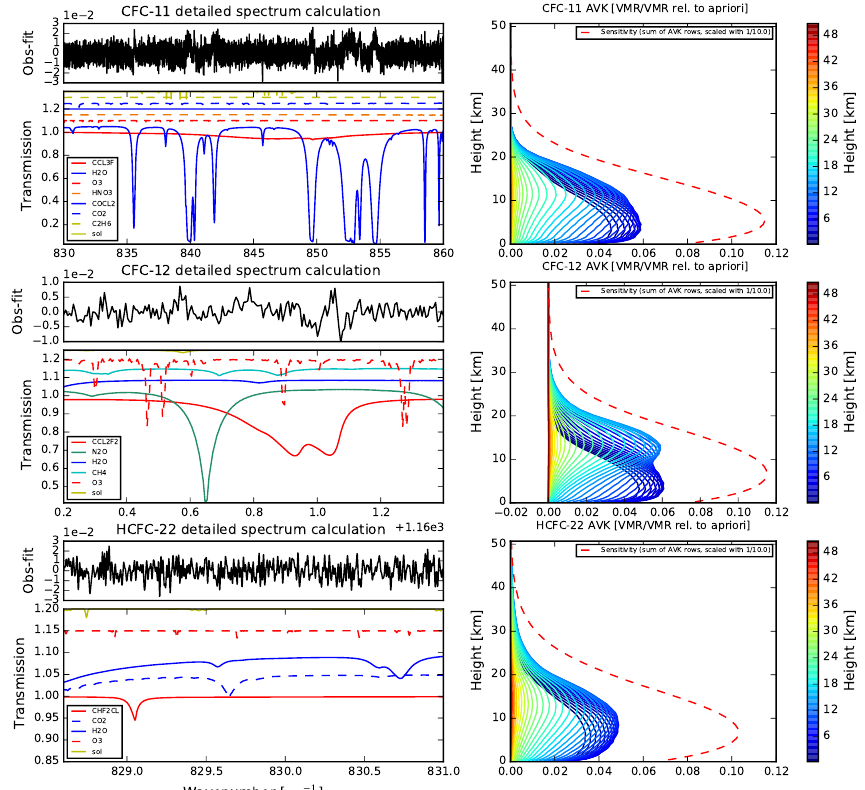
Figure 1. The typical spectrum and averaging kernels of CFC-11 (upper), CFC-12 (middle) and HCFC-22 (bottom) at St Denis. The left panels show the transmission and residual (observed − calculated spectrum) for the three retrieval microwindows, along with the absorption contribution from each specie. To clarify the absorption lines, the transmittance is shifted by 0.05 for each specie and solar line. Right panels show the averaging kernels for the target gases (no sensitivity above 50km). The solid lines represent the sensitivities at specific altitudes. The red dashed line is the sum of the row of averaging kernel scaled by 0.1, indicating the vertical sensitivity.